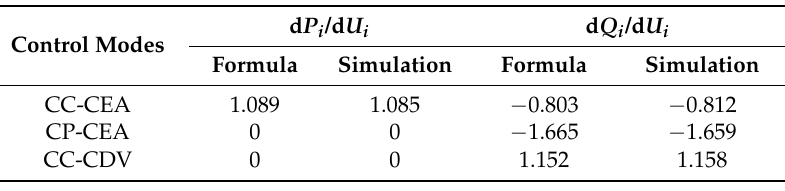
Table 1. Sensitivity calculation results of the CIGRE benchmark HVDC test model under three control modes.